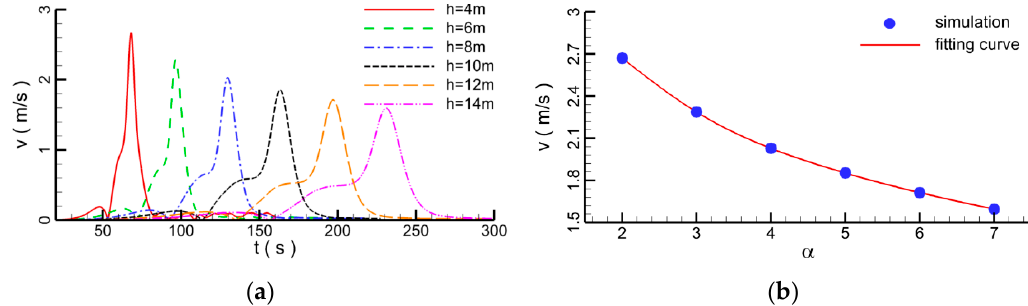
Figure 18. The variations of velocity at different water depths recorded at sensor P; ( a ) time series of velocity; ( b ) maximum velocity as function of water depth. α is the ratio of water depth h to the wave height H .